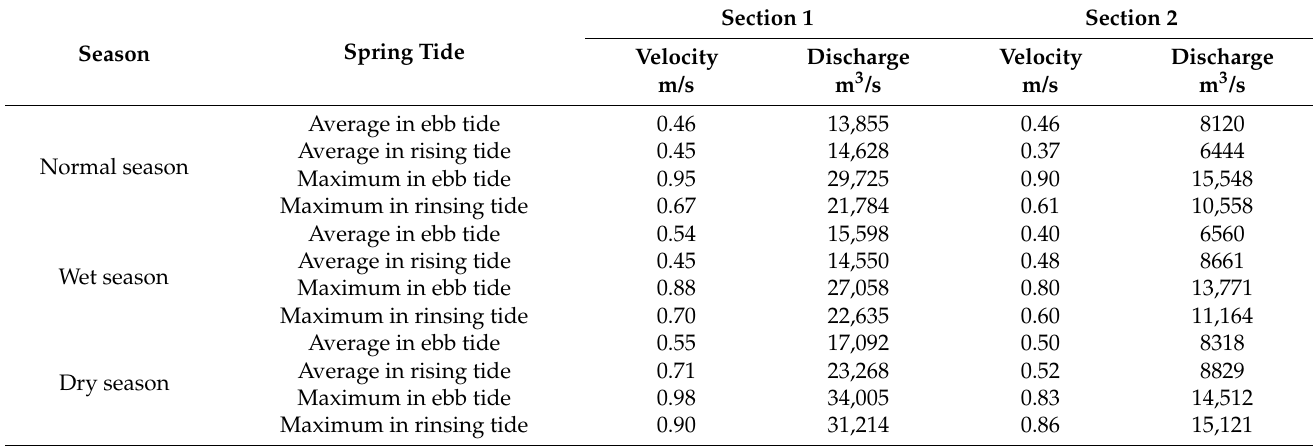
Table 1. Statistics of Section Navigation Observation Data in Spring Tide.